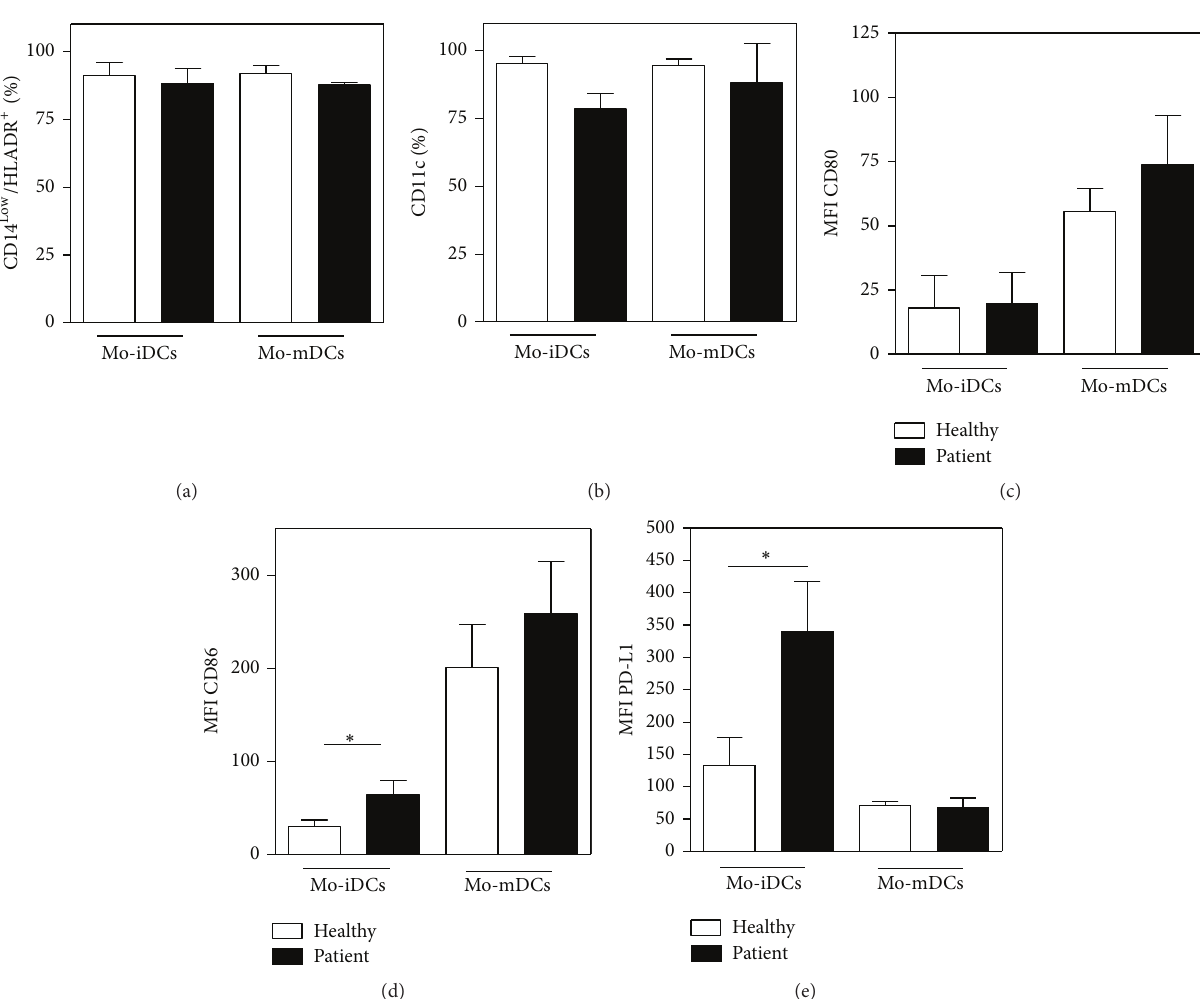
Figure 1: Patients’ immature Mo-DCs express higher levels of PD-L1. Blood monocytes from control, and breast cancer patient subjects were cultured in the presence of IL-4 and GM-CSF for seven days and, subsequently, characterized. Flow cytometry analysis showing grouped frequency of CD 14 Low /HLADR + (a) and CD 11 c + (b) cells and Mean Intensity Fluorescence (MFI) values of CD 14 Low /HLADR + gated cells to CD80 (c), CD86 (d), and PD-L1 (e) molecules in Mo-iDCs from healthy donors and breast cancer patients ( ∗ 𝑃 < 0.05 , two-tailed unpaired t- test; healthy 𝑛 = 5 ; patients 𝑛 = 9 ). (Mature Mo-DCs were activated by TNF-alfa for 48